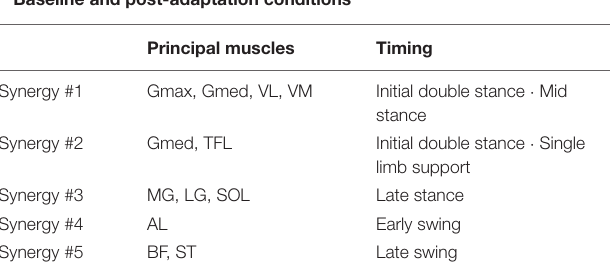
TABLE 2 | Principal muscles and main activation timing of each muscle synergy in the baseline and post-adaptation conditions. Baseline and post-adaptation